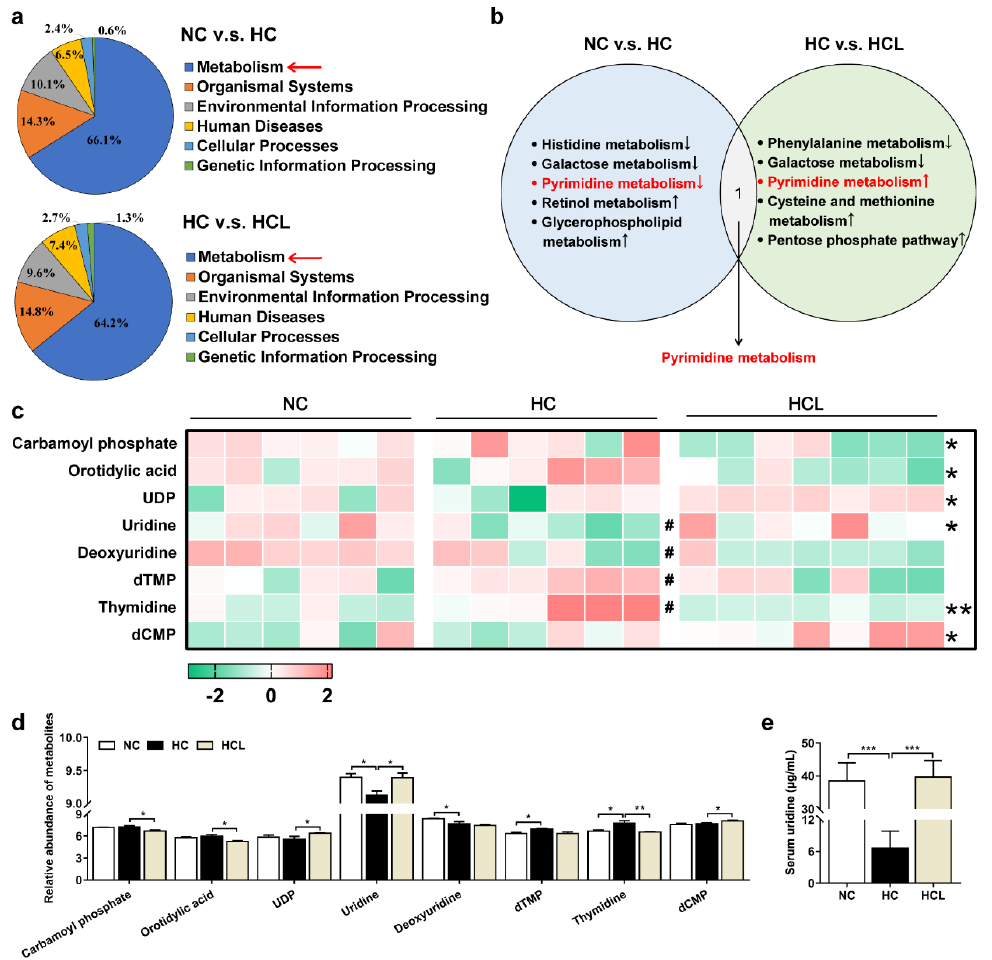
Figure 3. L. plantarum MR1 modulated the metabolic patterns in Nile tilapia. ( a ) Identification of differentially biological processes percentage in the HC-treated fish compared with the NC-fed fish or in L. plantarum MR1-treated fish compared with the HC-treated fish by liquid chromatography– mass spectrometry (LC–MS) analysis. ( b ) Annotation of the identical significant altered metabolism pathway in the three groups. ( c ) Heat map of selected differentially changed metabolites involved in pyrimidine metabolism (#, NC v.s. HC; *, HC v.s. HCL, #, p < 0.05, *, p < 0.05, **, p < 0.01). ( d )